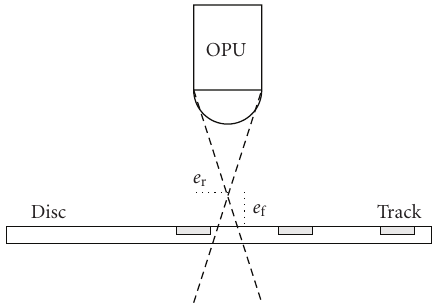
Figure 1: The focus distance, e f , is the distance from the focus point of the laser beam to the reflection layer of the disc; the radial dis- tance, e r , is the distance from the center of the laser beam to the center of the